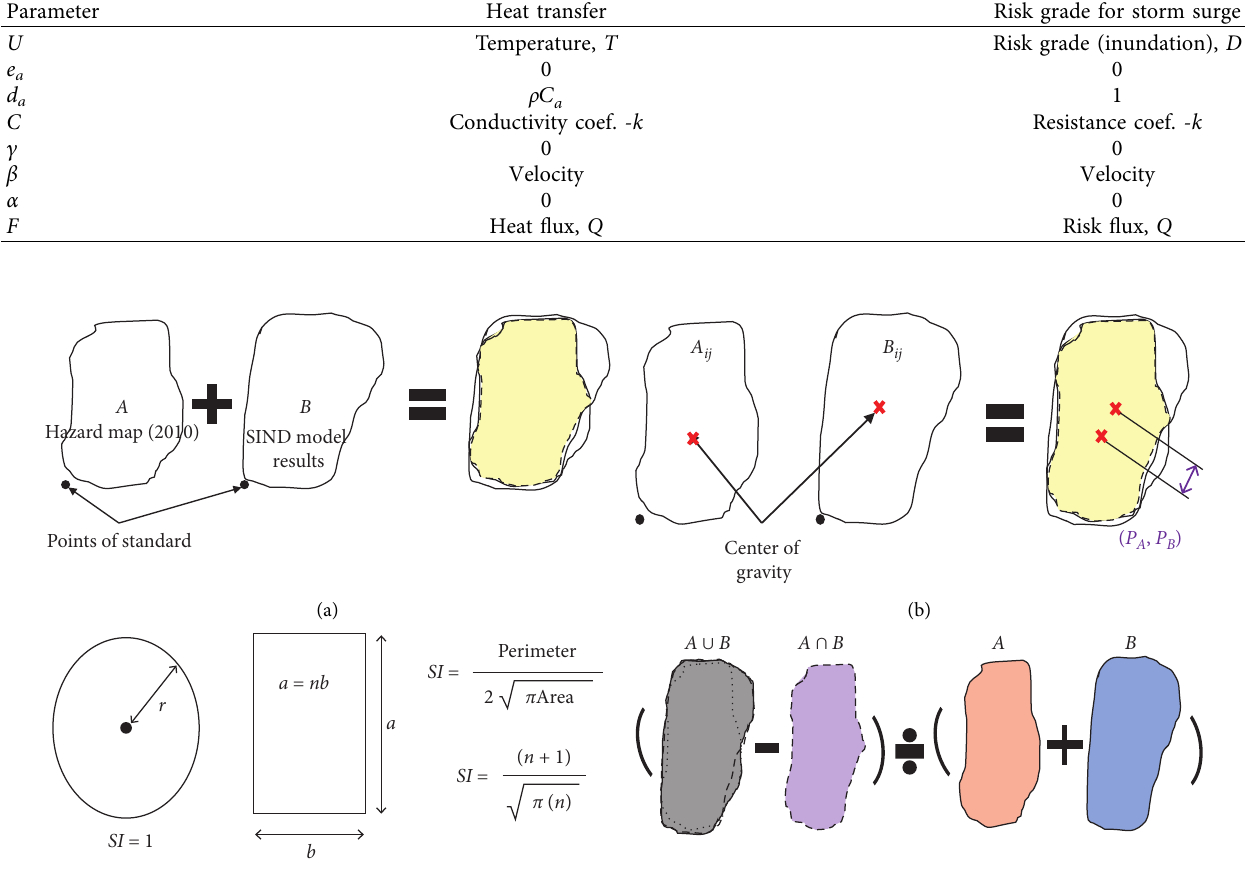
Table 2: SIND for storm surge in coefficient form.